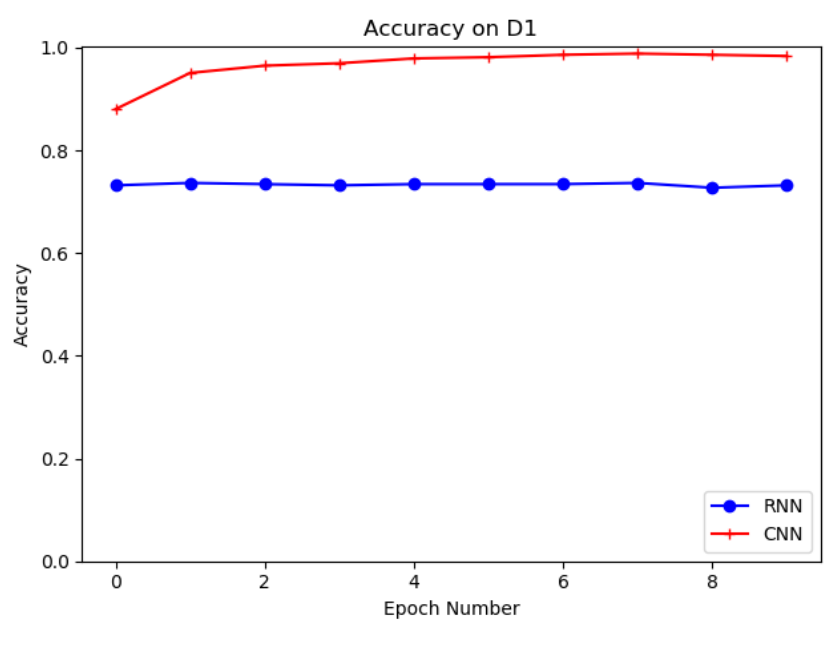
Figure 10. Evaluation on D1 with CNN, RNN.